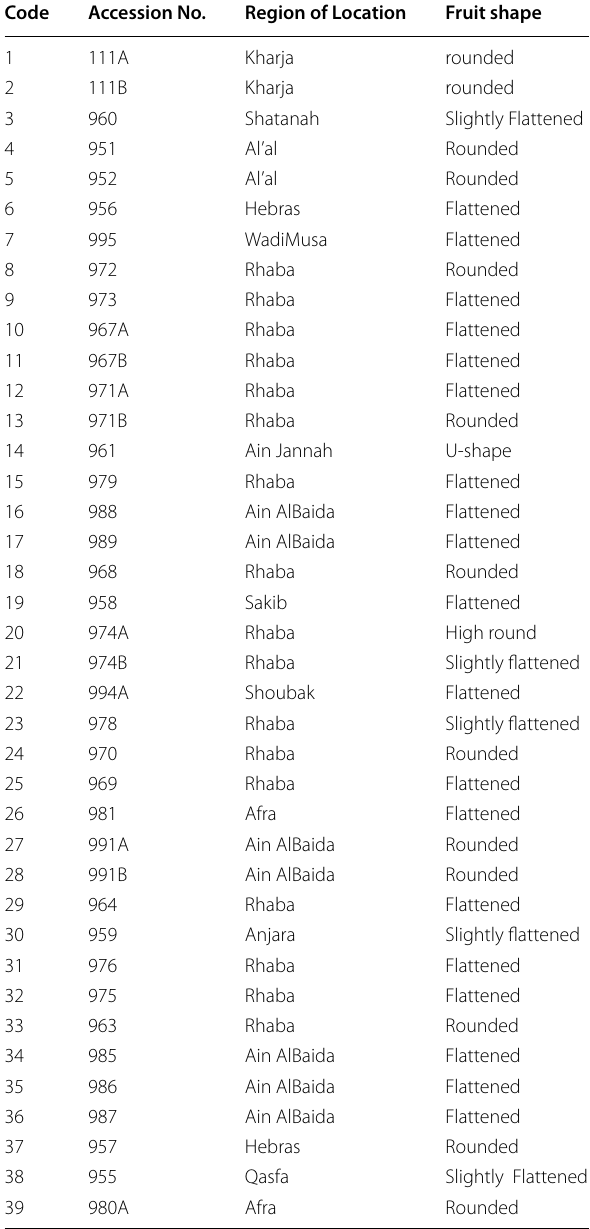
Table 1 General information regarding the collection including accession code and number, region of location in Jordan and fruit shape of tomato landraces used in this study